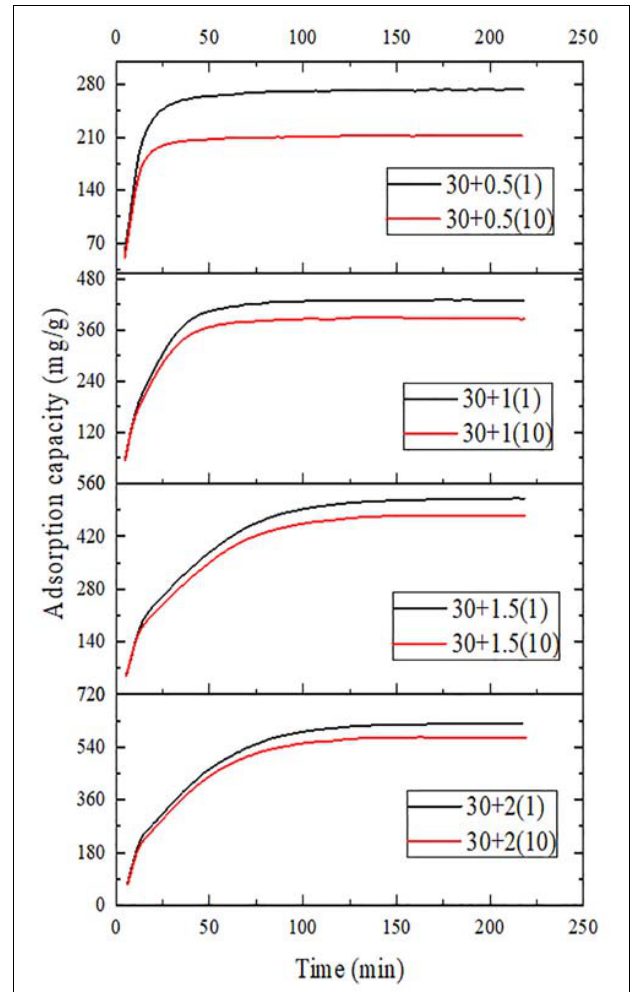
FIGURE 13 | The first and tenth adsorption curves under actual